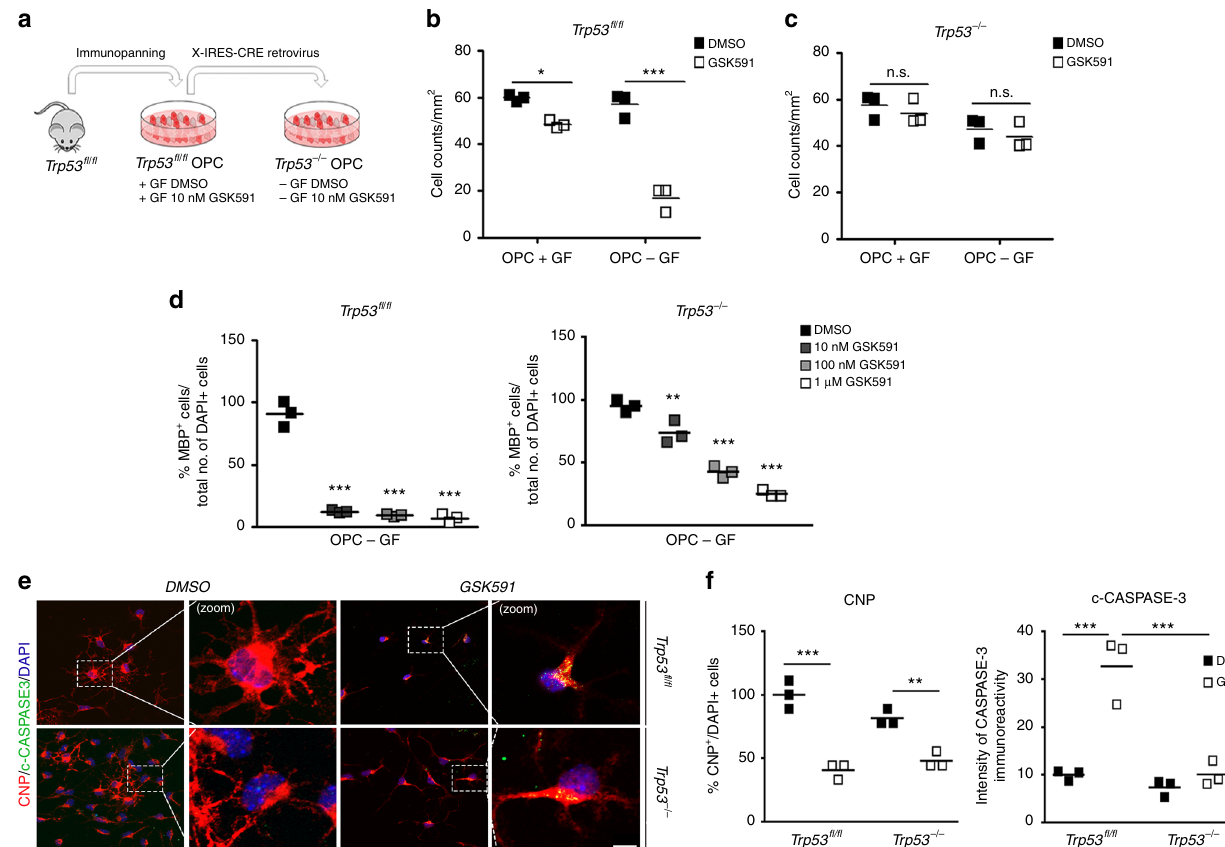
Fig. 5 Activation of p53-dependent apoptosis in progenitors treated with PRMT5 inhibitors. Effect of the pharmacological inhibitor of PRMT5 (GSK591) on cell viability and differentiation of primary cultures of OPCs from wild-type ( Trp53 fl / fl ) and p53 mutant ( Trp53 − / − ) mice. a Schematics of experimental conditions. b Average cell counts from three biological replicates of wild-type ( Trp53 fl / fl ) and ( c ) Trp53 -null ( Trp53 − / − ) OPC cultures in the presence ( + GF) and absence ( − GF) of growth factors, and with or without 10 nM GSK591. d Average MBP + cell counts from three biological replicates of wild-type ( Trp53 fl / fl ) and p53 mutant ( Trp53 − / − ) OPCs cultured in differentiating conditions in the absence (DMSO) or presence of increasing concentration of GSK591. One-way ANOVA, * p < 0.05, ** p < 0.01, and *** p < 0.001. e Representative confocal images of wild-type ( Trp53 fl / fl ) and Trp53- null ( Trp53 − / − ) OPCs cultured in differentiating conditions, with or without 10 nM GSK591 and stained with antibodies speci fi c for CNP (red), cleaved CASPASE-3 (c- CASPASE3, green), and DAPI (blue) (scale bar = 10 μ m). f Scatter plots of the average number of CNP + cell relative to total DAPI + cells and average intensity of cleaved CASPASE-3 staining from three biological replicates of GSK591-treated wild-type (228 total cells counted) and Trp53 -null OPCs (232 total cell counted) relative to untreated wild-type (240 total cells counted) and Trp53 -null (256 total cell counted). One-way ANOVA, ** p < 0.01, *** p < 0.001. n.s. nonsigni fi